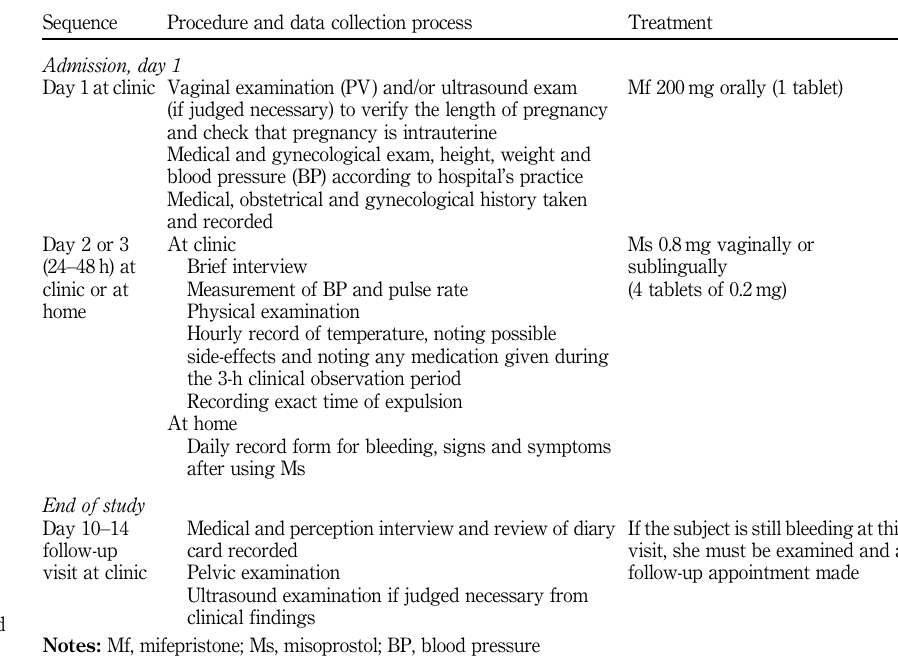
Table II. Treatment plan and study